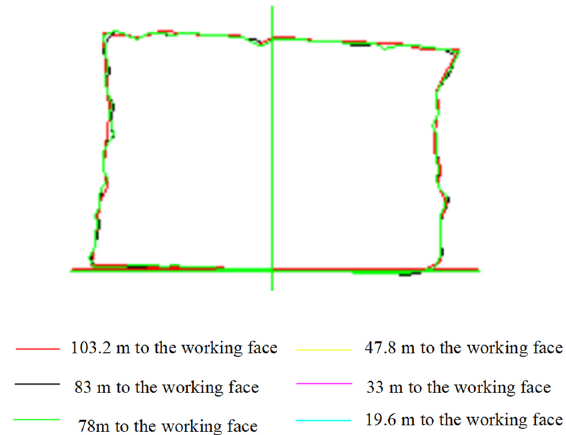
Figure 15. Full section scan of the roadway.